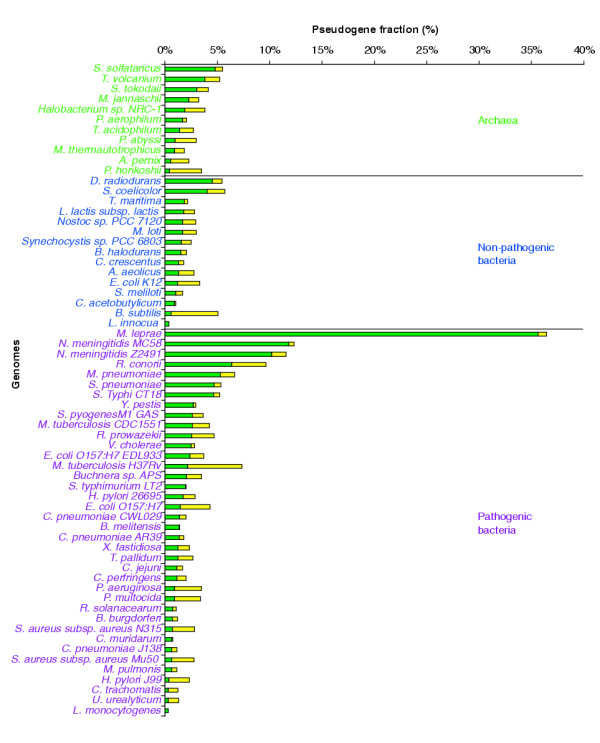
Fractions of pseudogenes in the 64 prokaryote genomes. The genomes are divided into three categories: archaea (green), non-pathogenic bacteria (blue) and pathogenic bacteria (purple). The yellow bars represent the fractions of pseudogenes that overlap with hypothetical ORFs, and the green bars represent those that do not overlap. Genomes in each category are sorted by the green bars.